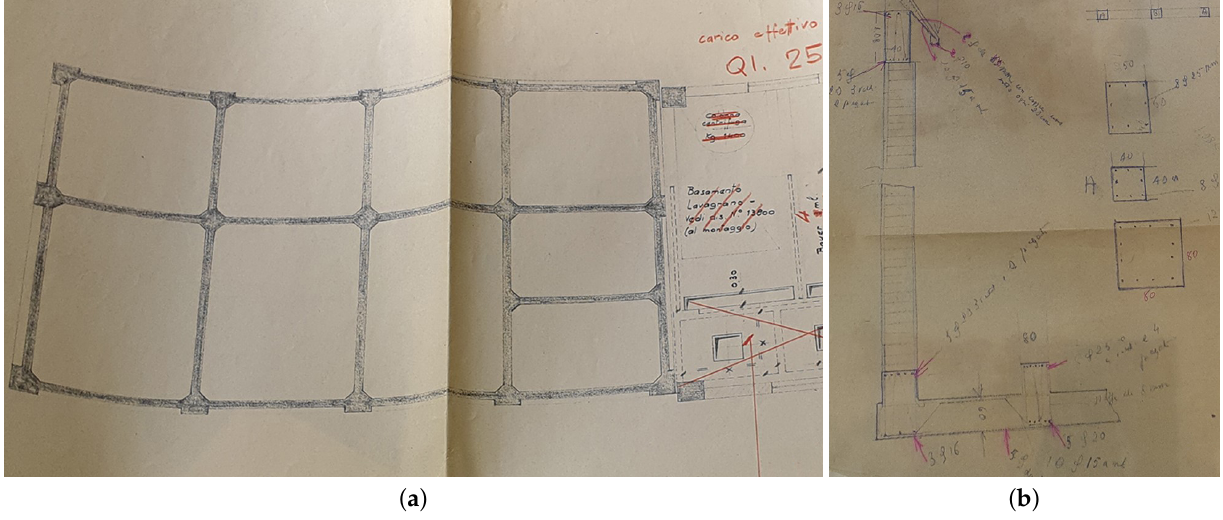
Figure 4. Project of the silos in RC of the late ’50s. ( a ) Original design drawings: plan; ( b ) Original design drawings: